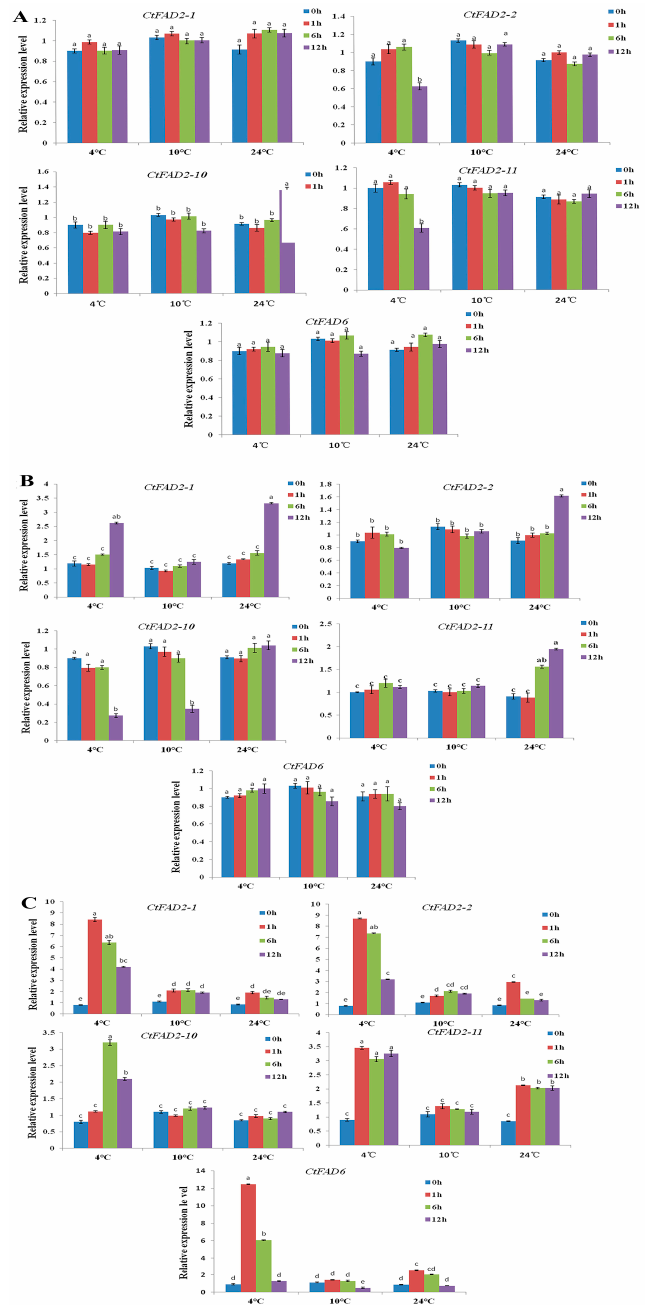
Figure 2. Effect of different temperatures on the relative expression levels of safflower CtFAD2-1 , CtFAD2-2 , CtFAD2-10 , CtFAD2-11 and CtFAD6 in roots, stems and leaves, and the expression levels were detected at 0, 1, 6 and 12 h after temperature stress. Note: The letter “( A )” represents the roots, the letter “( B )” represents the stems and the letter “( C )” represents the leaves. The transcription levels for three tissues were normalized against the samples under 16 °C, respectively. Each bar represents the mean. Error bars represent the standard deviation of the mean ( n = 3). The different alphabets above each bar indicate significant differences ( p < 0.05).